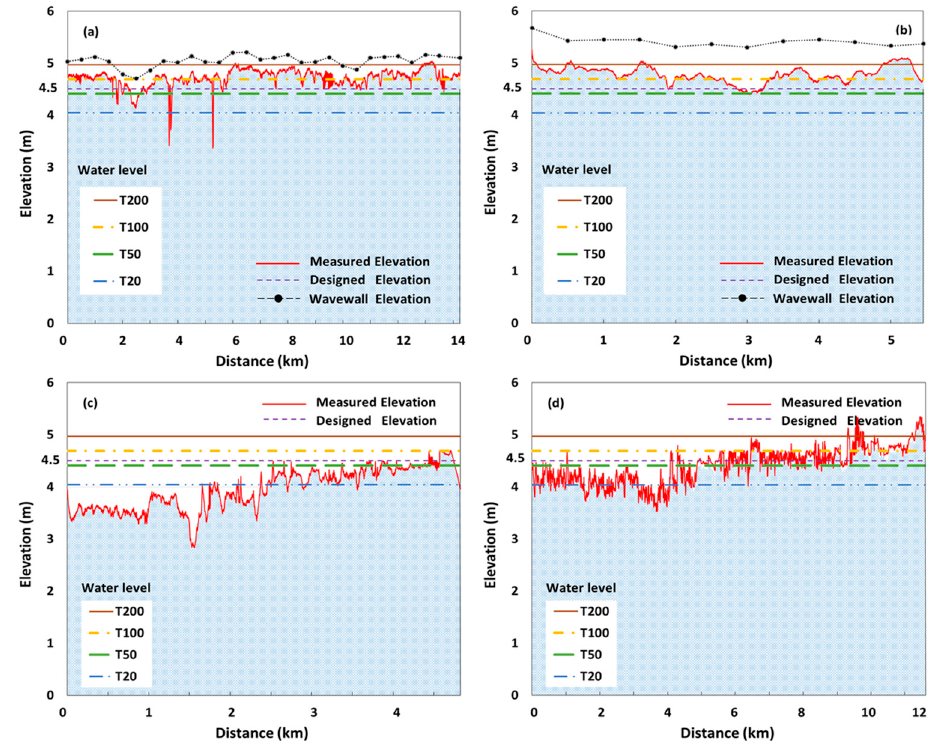
Figure 11. Comparison of the continuous crown elevation from the 0.5 m grid DEM against the designed elevation and the extreme water levels in the four return periods of 20, 50, 100, and 200 years when the sea level rises by 0.5 m for levees A ( a ), B ( b ), C ( c ) and D ( d ). The wave wall elevation (wave wall height plus levee crown elevation) is illustrated as the levee top height in levee A and B.